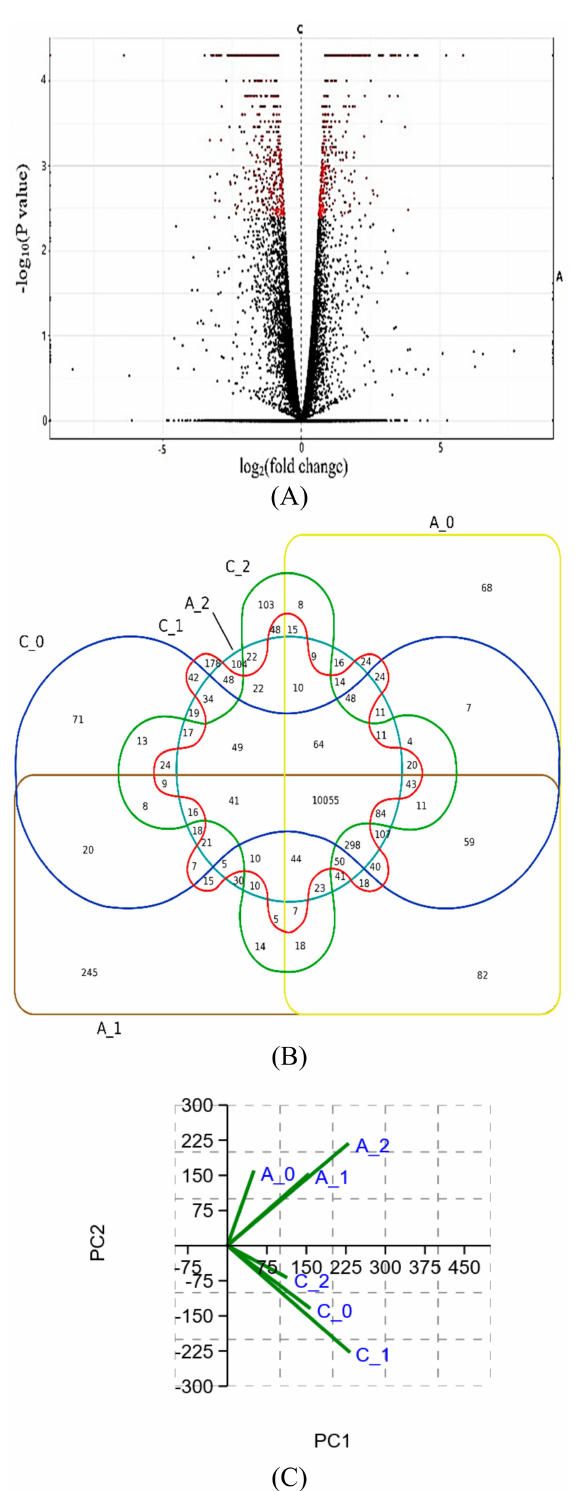
Figure 2. (A) Volcano plot is representing the relationship between fold-change and significance. Red points identified di ff erentially expressed genes between control and acidosis samples. We identified 1074 di ff erentially expressed genes ( p < 0.05), of which 627 were up-regulated and 447 genes were down-regulated in the acidosis group. (B) InteractiVenn plot to identify similarities and di ff erent gene expressions between each sample (control samples: C_0, C_1, C_2 and acidosis samples: A_0, A_1, A_2). (C) PCA plot shows that gene expression profiles of normal and acidosis tissue fall into distinct